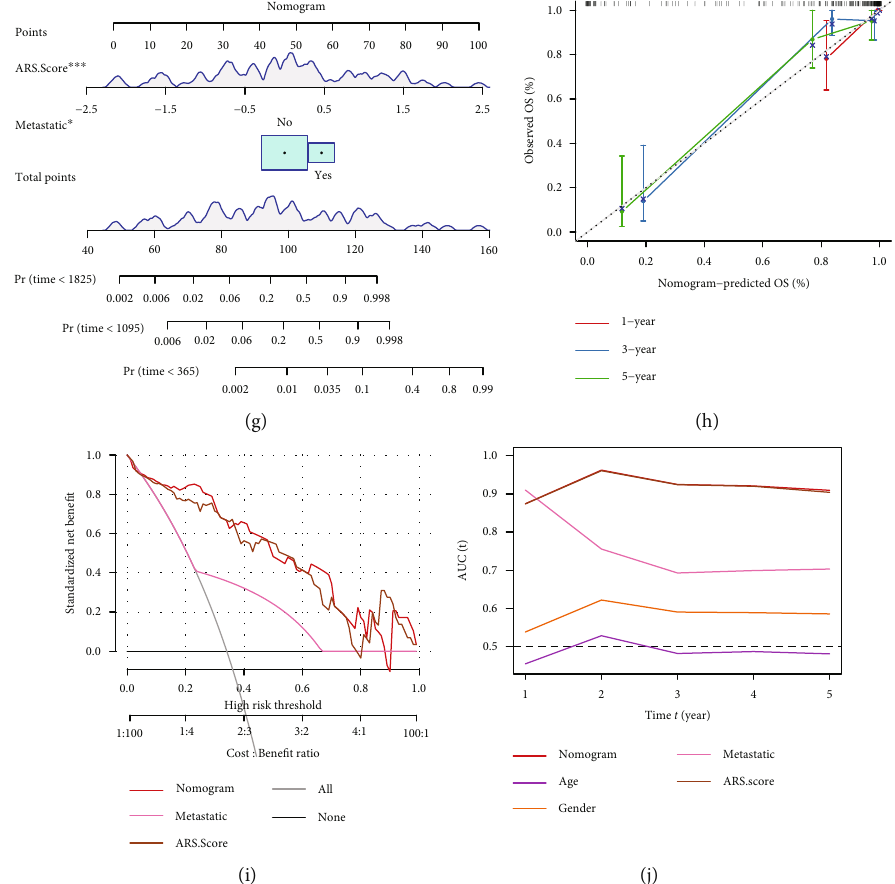
Figure 9: Construction and validation of a nomogram combining the risk signature and clinicopathological features. (a) Patients with full- scale annotations including risk score, metastatic, gender, and age were used to build a survival decision tree to optimize risk strati fi cation. (b) Comparison of OS of the four subgroups obtained from the decision tree analysis in the TCGA cohort. (c) Correlations between the four subgroups and the risk signature. (d) Correlations between the four subgroups and molecular subtypes. (e) Univariate and (f) multivariate Cox analyses of risk score and clinicopathological characteristics in the TCGA cohort. (g) A nomogram combining risk signature and metastasis was generated in the TCGA cohort. (h) Comparison of the calibration curve for 1-, 3-, and 5-year OS of nomogram. (i) Decision curves for the clinical net bene fi t of each model in comparison to all or none strategies. The x -axis indicated the threshold probability, and the y -axis indicated the net clinical bene fi t. (j) Time-dependent ROC curves comparing the prognostic accuracy of nomogram, age, gender, metastasis, and risk score in the TCGA